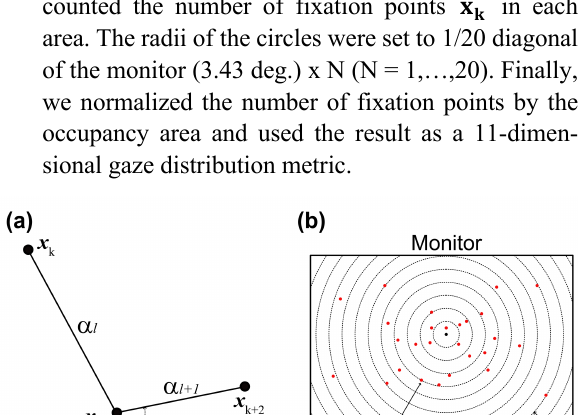
) was ! ) 𝒌#𝟏 ,𝒙 𝒌 ,𝒙 𝒌%𝟏 ). These &#’ ,𝛼 &